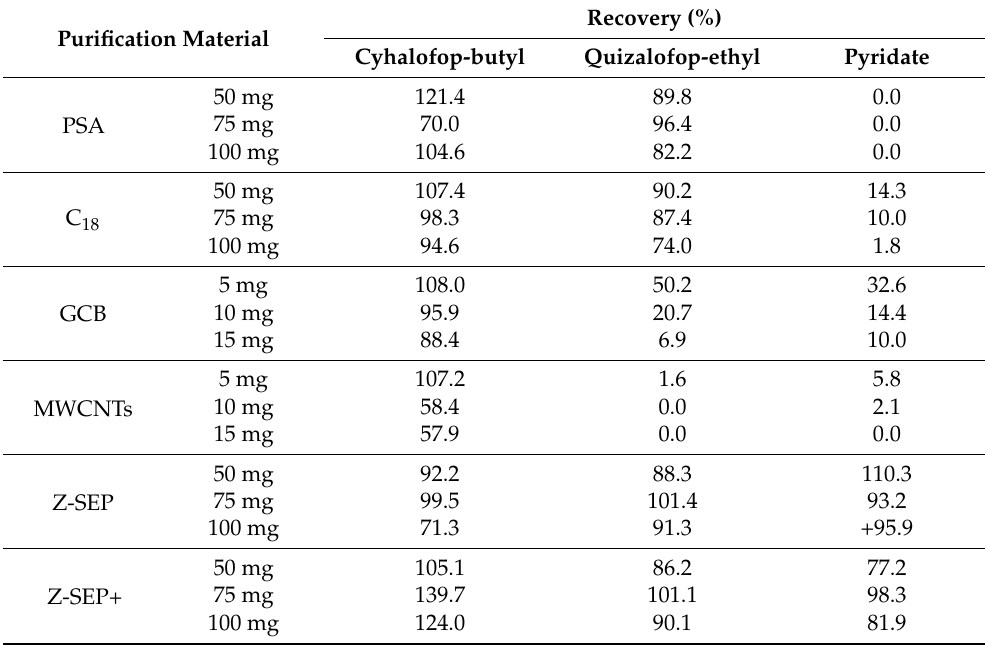
Table 4. Optimization of sorbent type and amounts in terms of analyte